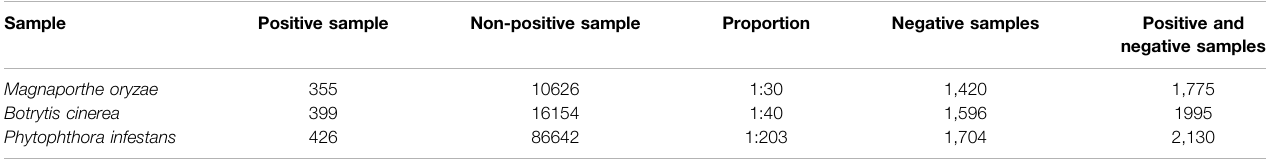
TABLE 5 | Statistics of positive and negative